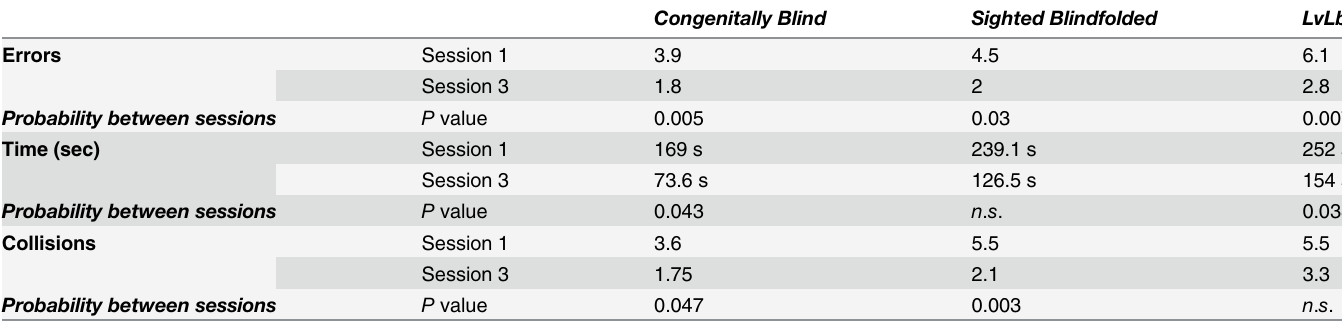
Table 2. Results Real